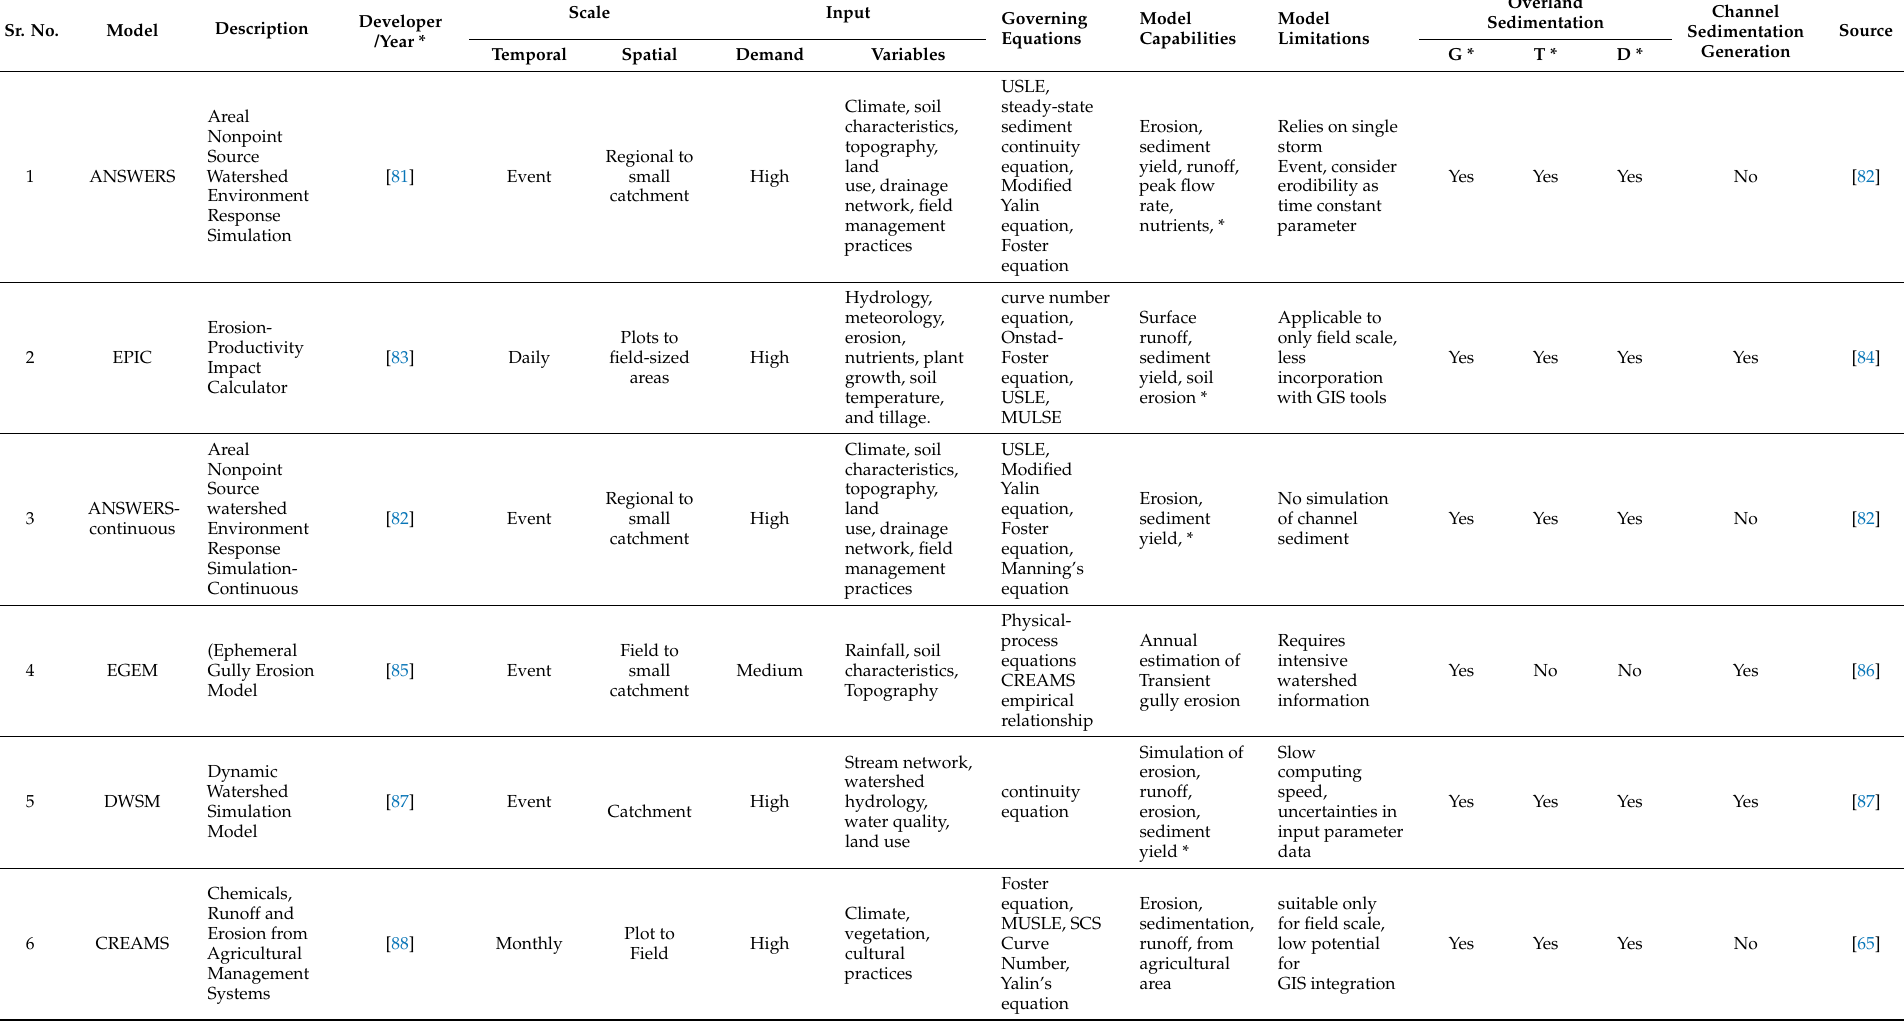
Table 5. Physically based soil erosion